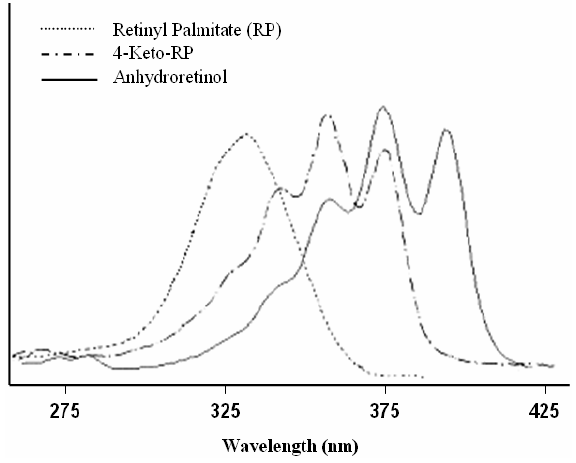
Figure 4: UV-visible absorption spectra of RP (--------), 4-keto-RP ( _. _. _. _ ), and anhydroretinol (AR) ( ______ ). Following irradiation of RP with the high output UVB light, the compounds that eluted at 9.8 and 10.2 min (Figure 3) each contained more than one